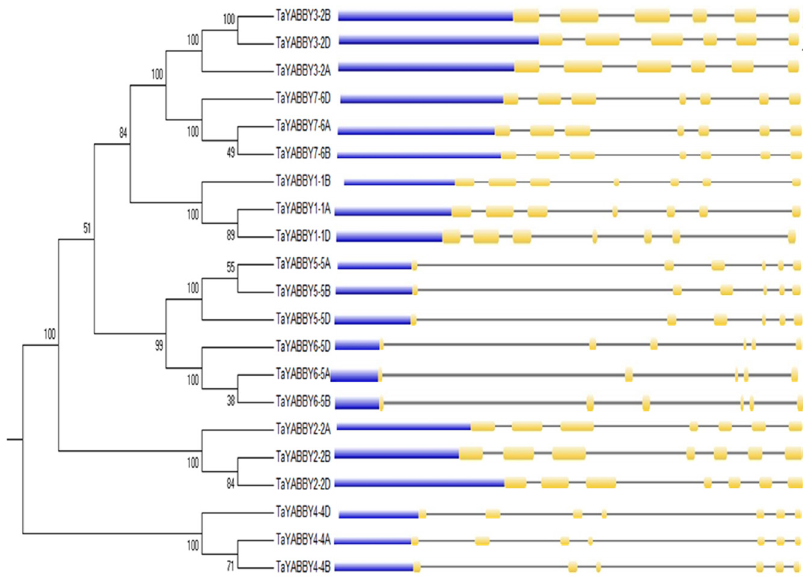
Figure. 2. Phylogenetic relationships and gene structures of TaYABBY genes . Figure 2. Phylogenetic relationships and gene structures of TaYABBY